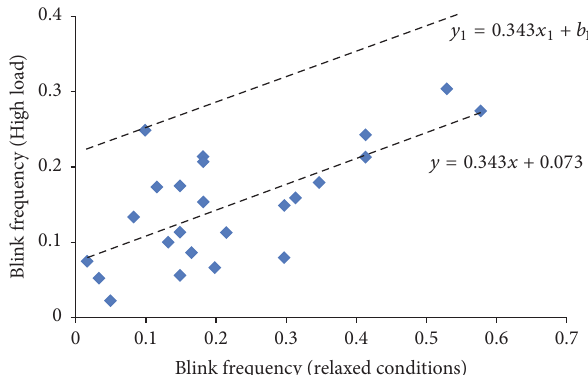
Figure 5: Blink frequency in high load and low load state is linear correlation.